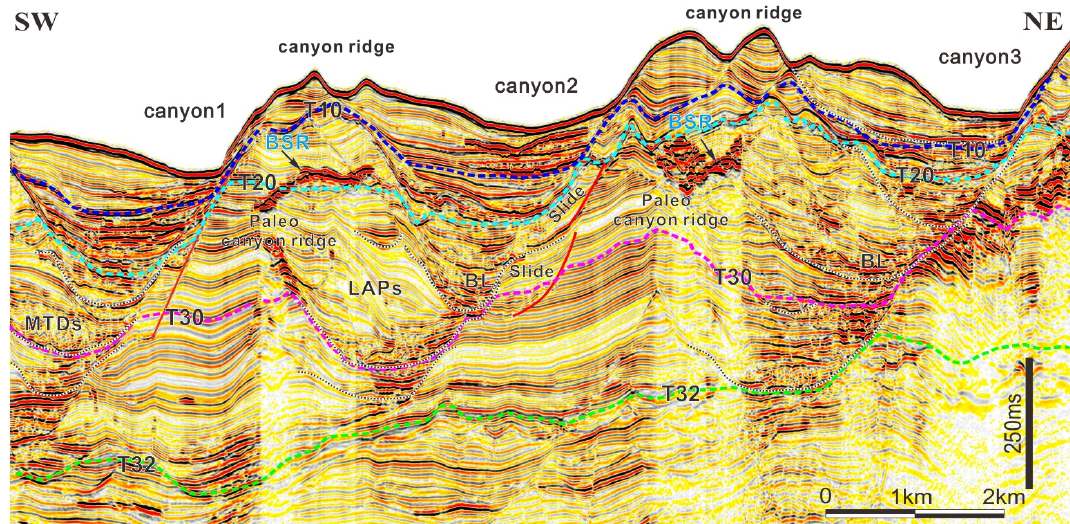
Figure 9. Characteristics and distribution of BSRs in the profile perpendicular to canyons.